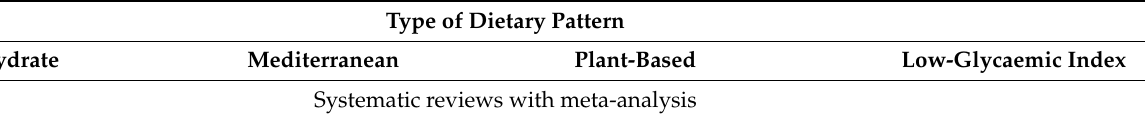
Table 3. Systematic reviews comparing dietary patterns (with control diets) included in this review.